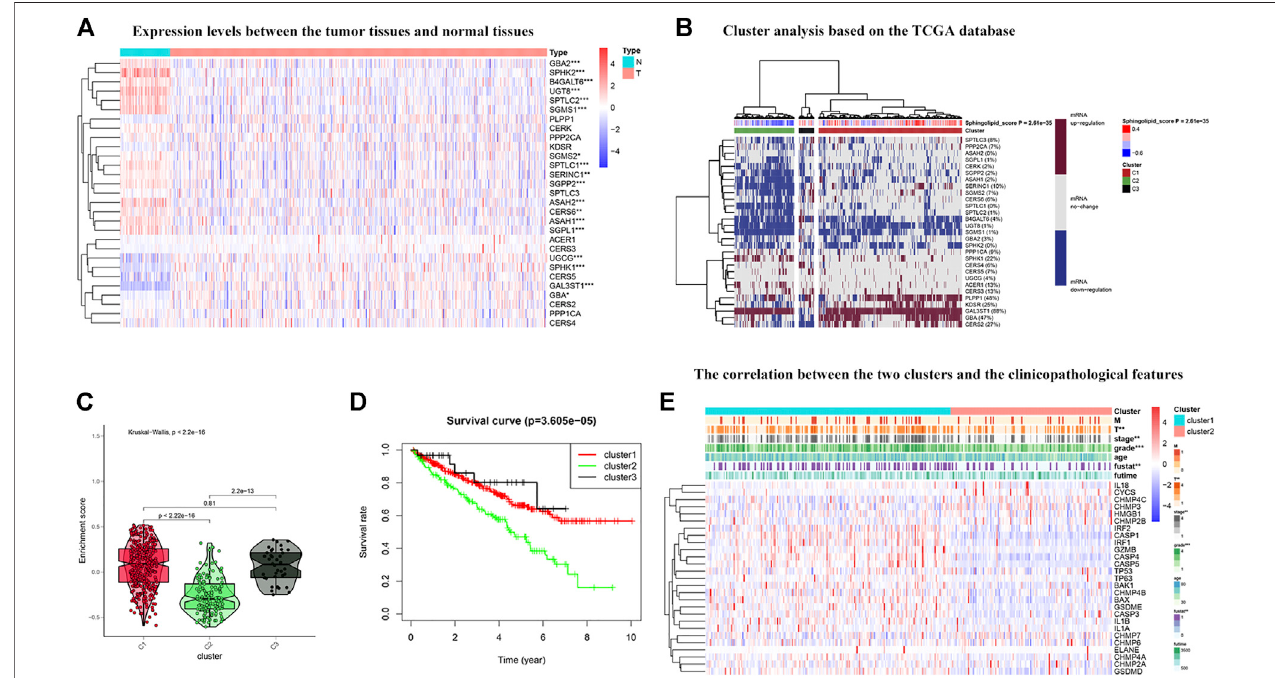
FIGURE5| Clusteranalysisbasedonthesphingolipidscores. (A) Theheatmapshowsthedifferenceinexpressionbetweennormaltissuesandtumortissues.The color in the block on the right represents gene regulation; red represents upregulation, and blue represents downregulation. N (blue) represents the normal sample, T (red) represents the tumor sample (*: p < 0.05, **: p < 0.01, ***: p < 0.001). (B) Heat map of three clusters: active sphingolipid-related genes (Cluster 1 or C1), inactive sphingolipid-related genes (Cluster 2or C2) and generasl sphingolipid-related genes(Cluster 3 or C3). The percentage of patients whose genes are upregulated is given on the right side of the fi gure. In the color bar on the right side, red represents mRNA upregulation, blue represents mRNA downregulation, and gray represents mRNA no-regulation. Thefour color bars represent the sphingolipid score; red representspositive values, and bluerepresentsnegativevalues. (C) Theviolinplotshows the enrichment scores of the three clusters. From high to low: Cluster 1, Cluster 2, and Cluster 3. The p -values are displayed above the clusters. (D) The survival curves associatedwiththethreeclusters.ThesurvivalrateofCluster2islowerthanthatofClusters1and3.TheredlinerepresentsCluster1,thegreenlinerepresentsCluster2, and the black line represents Cluster 3. The abscissa represents the number of years and the ordinate represents the survival probability. (E) The heat map shows the correlation between the two clusters and the clinicopathological features. In the color bar on the right side, red represents gene upregulation, and blue represents gene downregulation (*: p < 0.05, **: p < 0.01, and ***: p < 0.001).